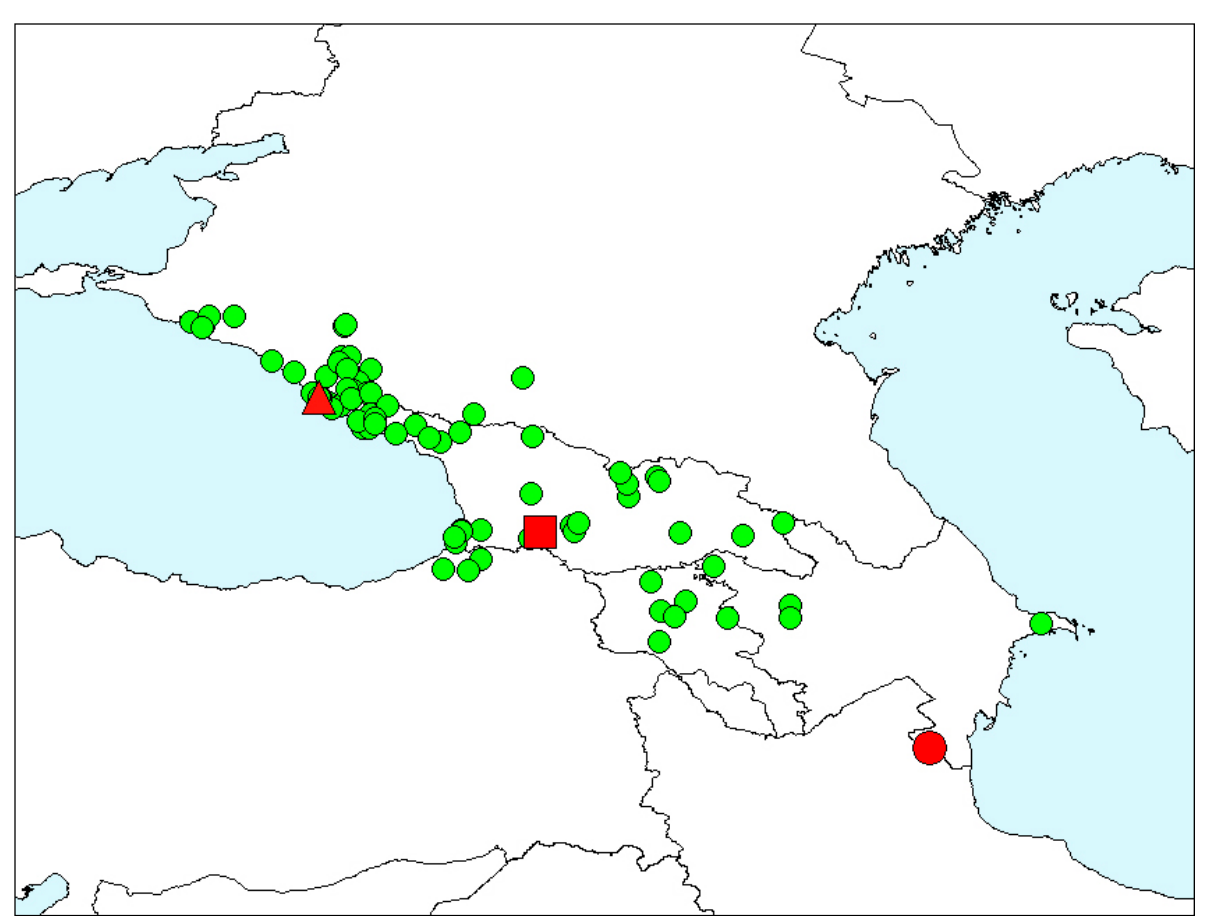
Figure 5. Timarcha hummelii , material examined. Red figures—type localities of the nominal taxa: triangle— T. hummelii starcki , square— T. armeniaca , circle— T. hummelii . Green circles—non-type specimens.